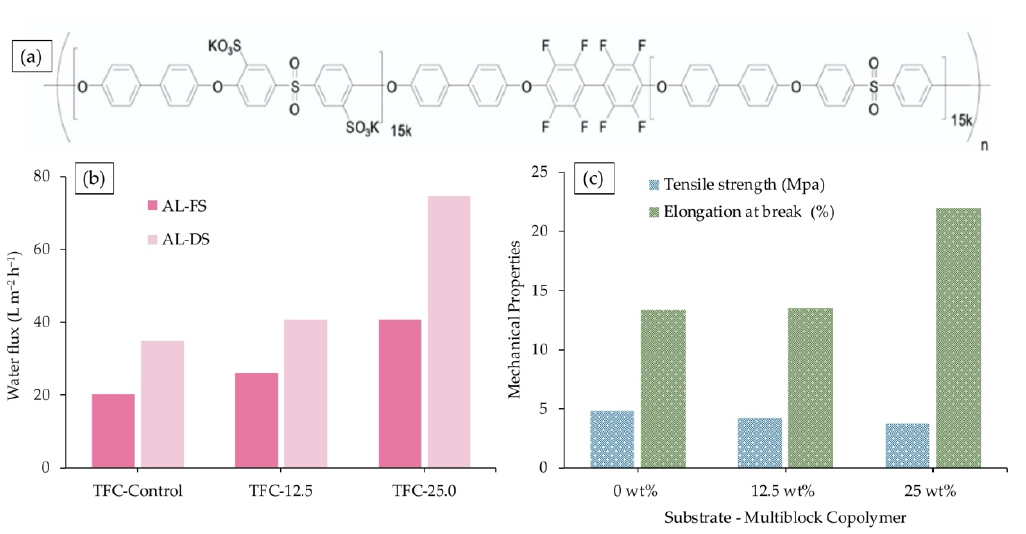
Figure 5. ( a ) Chemical structure of disulfonated poly(arylene ether sulfone) multiblock copolymer. ( b ) Water flux of membranes at different multiblock copolymer contents using water as feed and NaCl as draw solution. ( c ) Mechanical properties of substrate with 0 wt %, 12.5 wt %, and 25 wt % multiblock copolymer [120]